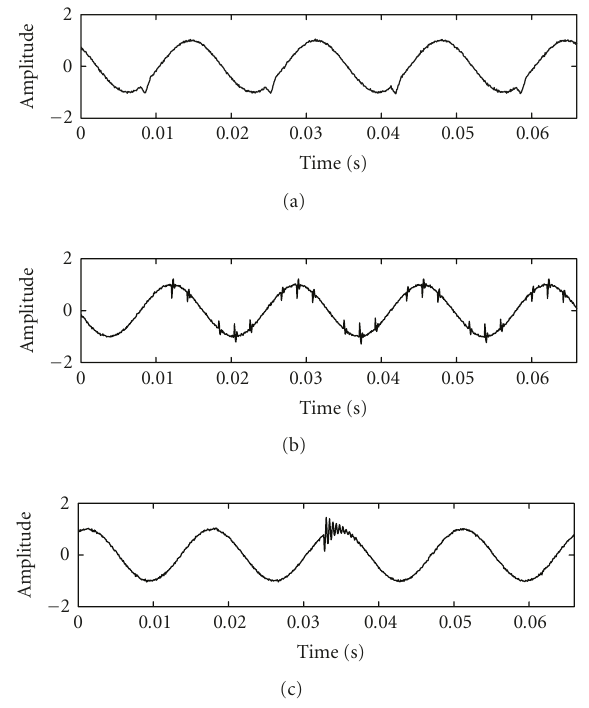
Figure 17: Disturbances associated with the vector u . (a) is a sample of impulsive transient, (b) is a sample of notch, and (c) is a sample of a damped